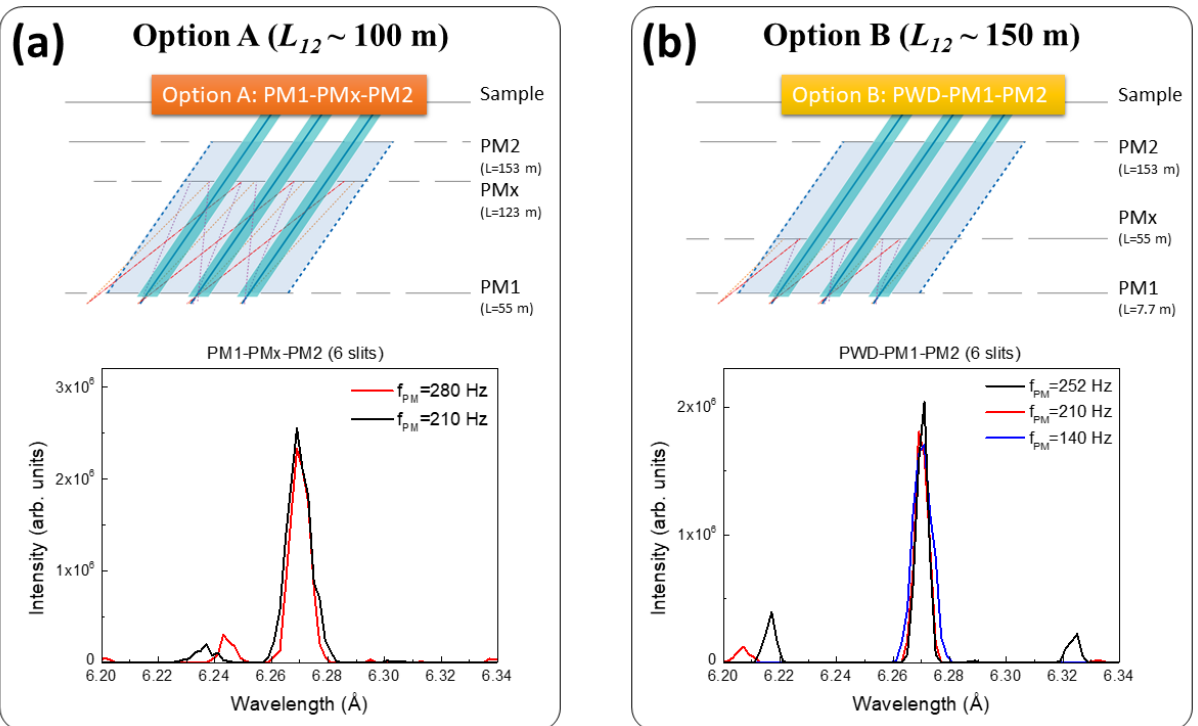
Figure 7. ( a ) Sketch illustrating only the pulse multiplication chopper cascade using six slits for Options A ( a ) and B ( b ), together with their respective wavelength and TOF spectrum at the sample position with PMx chopper running at various speeds.